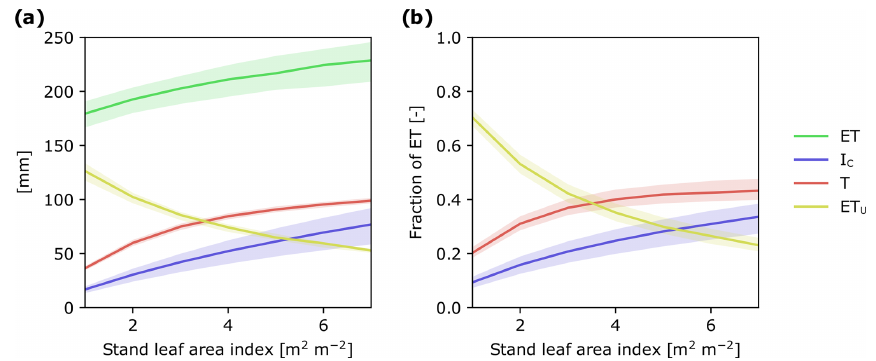
Figure 6. Modeled response of ET and its flux components to changes in stand LAI: (a) as cumulative water fluxes and (b) as a fraction of ET during July–October 2016. In simulations, weather forcing and relative LAD profiles were kept constant and stand LAI varied from 1 to 7m 2 m − 2 . The shaded ranges correspond to model parameter ranges (see Tables S2 and